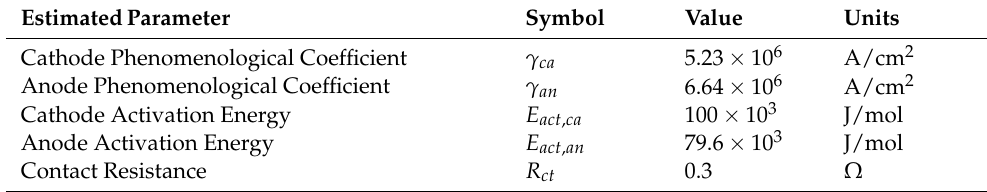
Table A2. Estimated